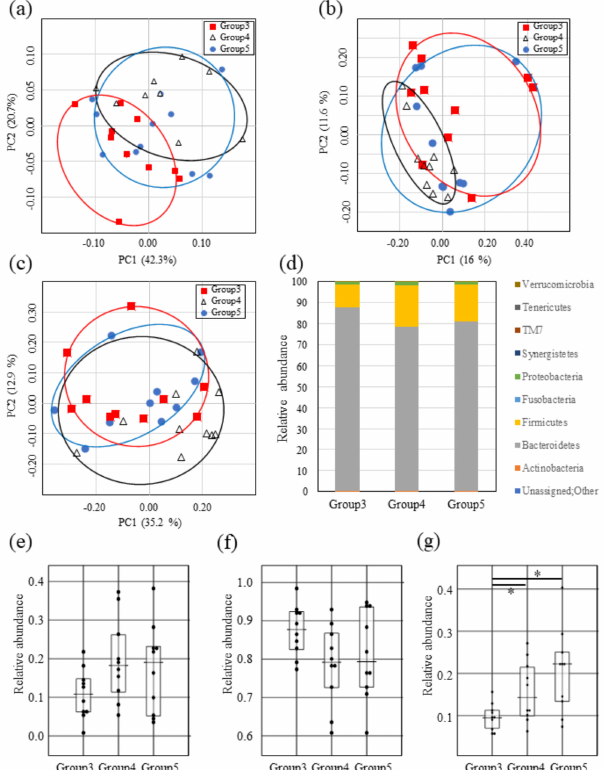
Figure 3. Comparison of the fecal microbial composition in mice fed with lantibiotics. Principal- coordinate analysis (PCoA) of mouse fecal microbiota fed with S. mutans supernatant containing Mutacin I (red circle), without Mutacin I (white triangle) or medium only (blue circle). PCoA plots were performed based on weighted UniFrac ( a ), unweighted UniFrac ( b ), or Bray-Curtis ( c ) distances of the mouse fecal bacterial communities. ( d ) Comparison of relative abundance of OTUs in the bacterial composition of the mouse fecal samples at phylum level between the S. mutans culture supernatant group (Group 3; n = 10), without lantibiotics group (Group 4; n = 10) and medium only group (Group 5; n = 10). ( e ) Relative abundance based on OTUs in Firmicutes of the mouse fecal samples between groups. Relative abundance based on OTUs ( f ) or quantitative Real-time PCR in Bacteroidetes of the mouse fecal samples between groups. ( g ) Relative abundance based on quantitative Real-time PCR in Firmicutes of the mouse fecal samples between groups. All of the boxplots for each group represent the interquartile range (25–75%) and the line within the box represents the median value. Kruskal-Wallis H-test was used to test for significant differences among sample distances and Mann-Whitney U-test was then used for significant differences between groups. Asterisks show significant differences ( p <